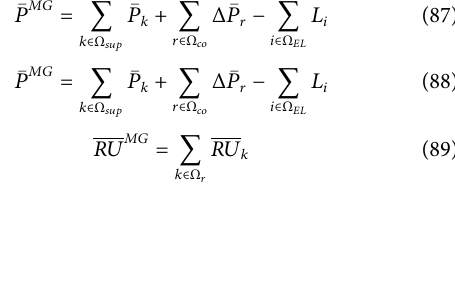
Algorithm 1. Column-and-Constraint Generation Algorithm.